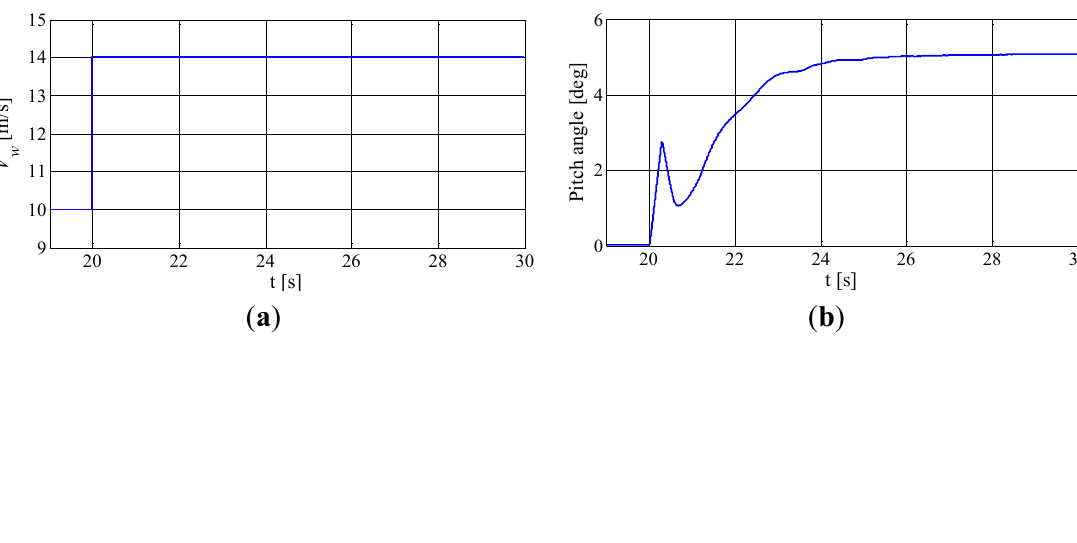
Figure 8. Simulation results of wind speed step up. ( a ) Wind speed; ( b ) Pitch angle; ( c ) Generator speed; ( d ) Power of D-PMSG EPT and super-capacitor; and ( e ) EPT low voltage side DC